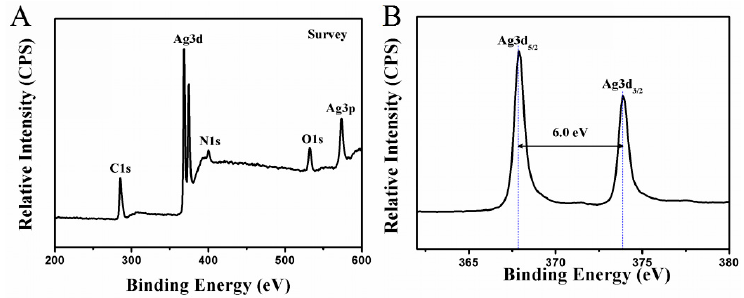
Figure 4. XPS spectra of AgNP@ESM composite: ( A ) survey; ( B ) Ag 3d.